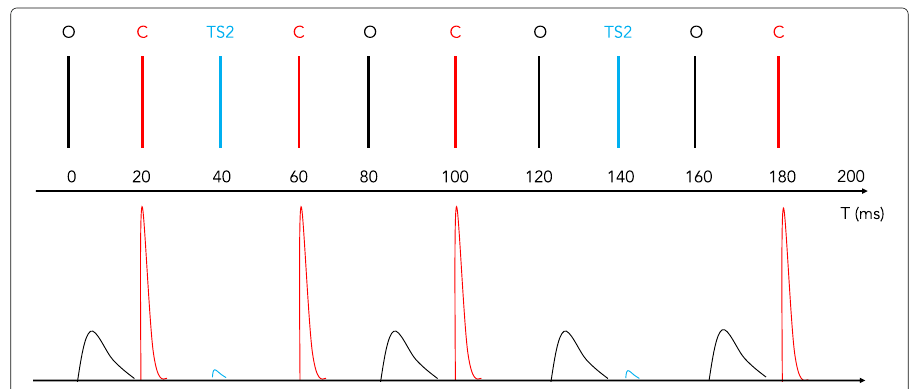
Fig. 14 Sketch of the arrival signals in a window of 200 ms, when the chopper works at 25 Hz (CRISP). The black identifies the signal passing throw the chopper (O = open), the red colour is used when the neutron beam hits the chopper without passing through (C = close). In this case a strong spike is expected at the detector. One every five pulses is sent to the Target Station 2 (TS2), blue in figure. A low background can be